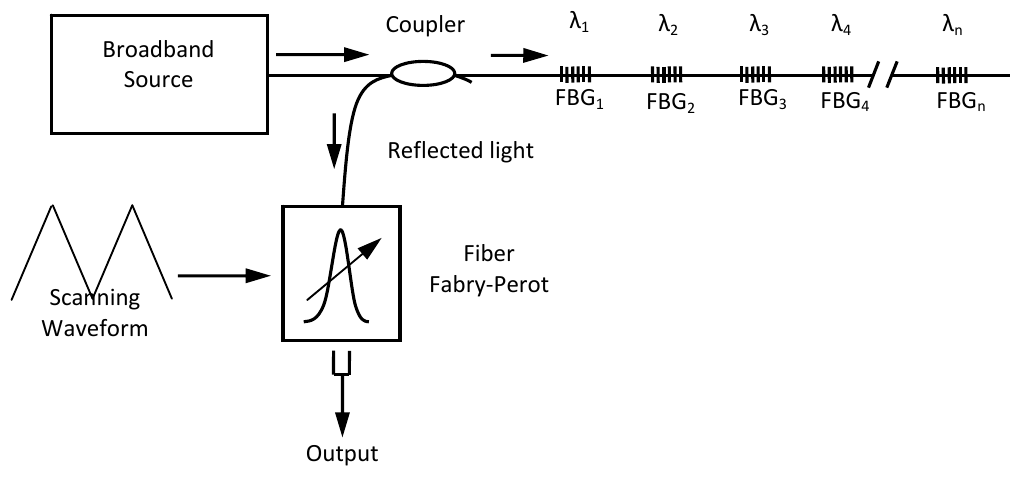
Figure 11. Illustration of scanning filter fiber Bragg grating (FBG) detection